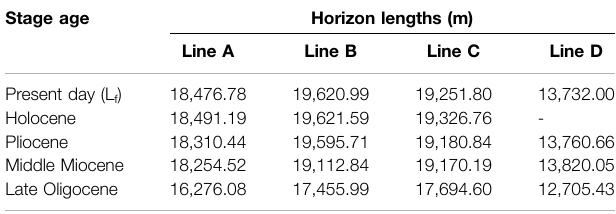
TABLE 2 | Horizon lengths at undeformed stage.